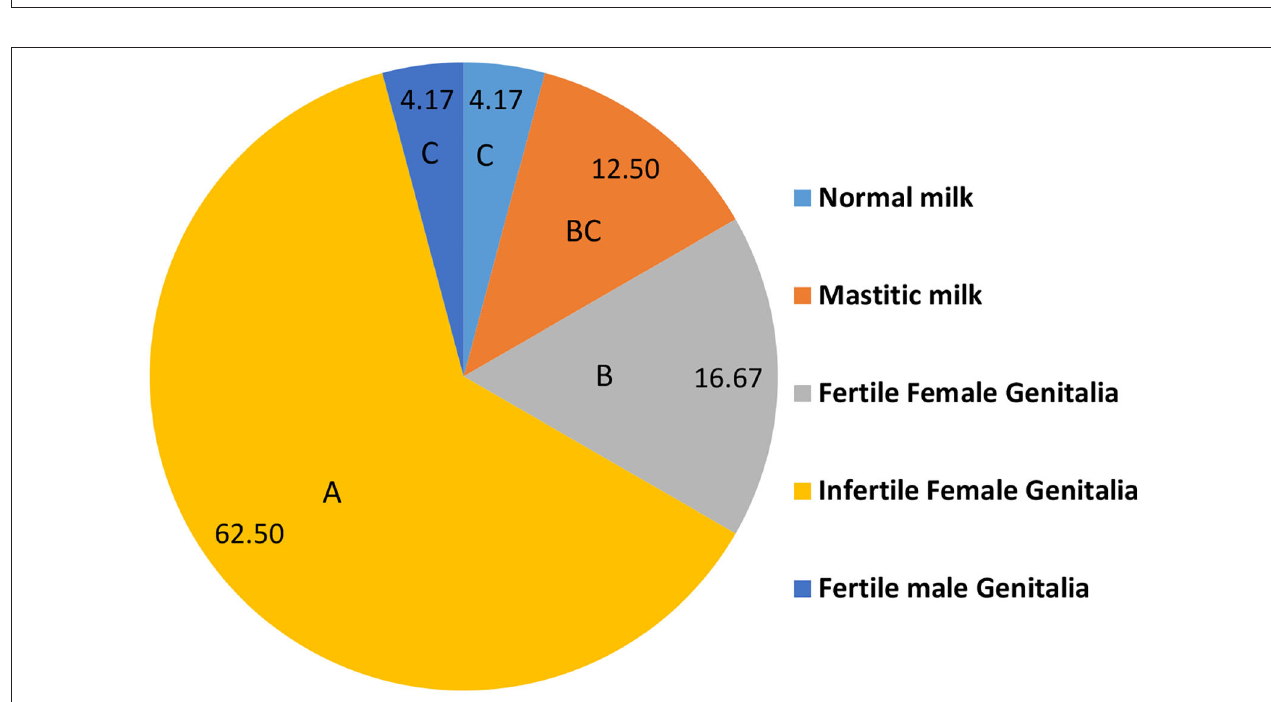
FIGURE 2 | The distribution of isolated C. albicans in different positive samples ( n = 48). A.B.C Percentages carrying different capital letters differed significantly ( p ≤ 0.05).